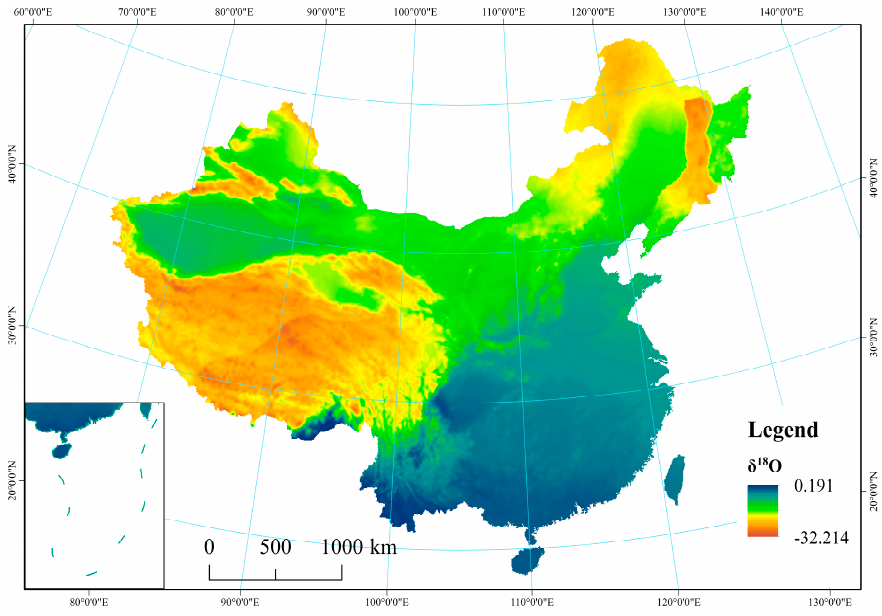
Figure A1. Spatial distribution of δ 18 O in precipitation across China.